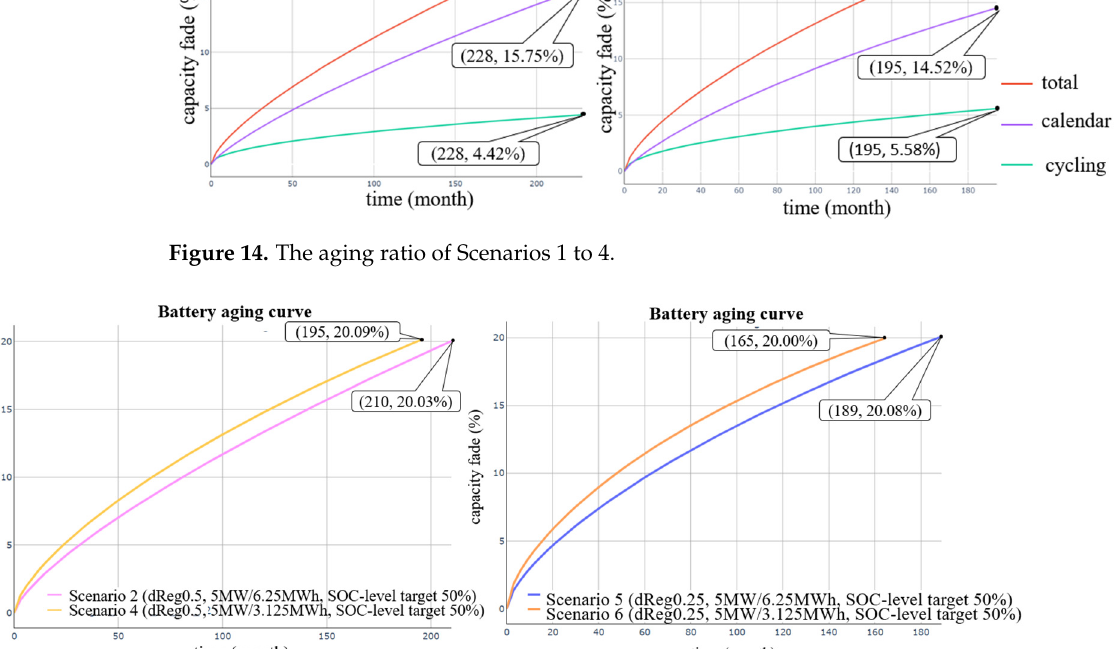
Figure 14. The aging ratio of Scenarios 1 to 4.